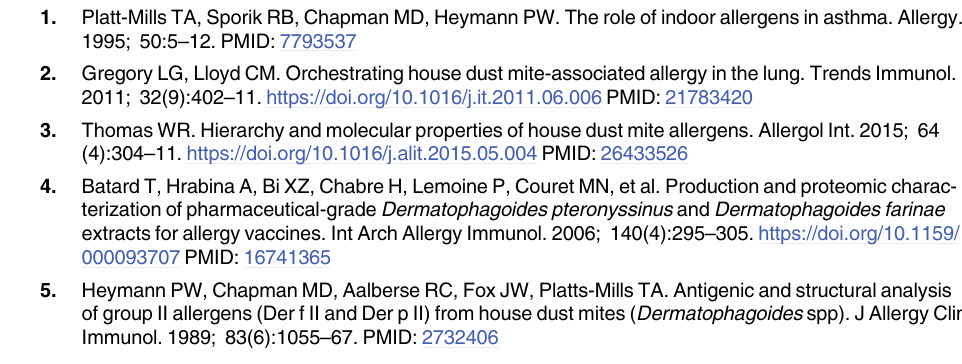
S2 Fig. Representative images of H&E stained lung sections of (A) sham mice (average grade 0.8), (B) allergenic mice treated with L-Der p 1 (averaged grade 1.5); (C) allergic mice treated with L-CE, L-Der p 2 or L-Com (average grade 2.0) and allergic mice treated with L-PBS (placebo) (average grade 2.65) that were correspond to the histologic grades at PP in Fig 3. S1 Table. Oligonucleotide primers used for the quantitative real-time PCR (qRT-PCR) in monitoring the cytokine gene expressions. S2 Table. Histologic grades and features of lung sections of normal and Dp-CE allergen- ized